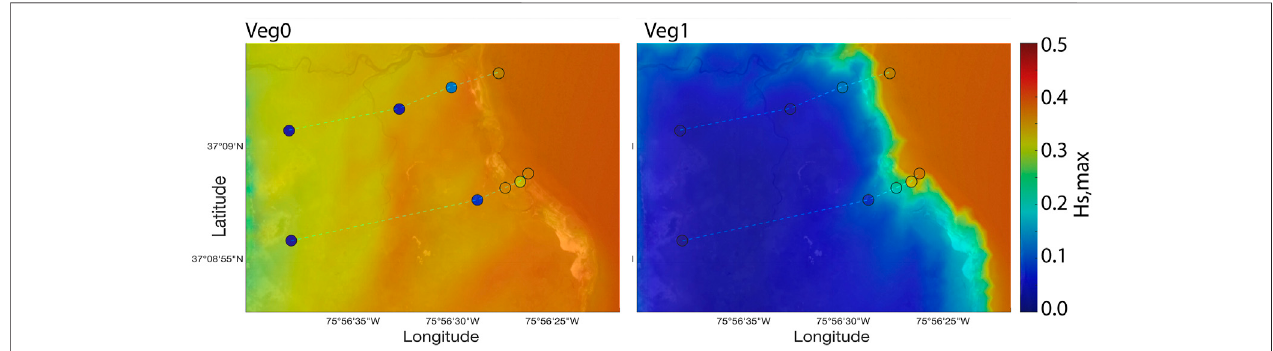
FIGURE 11 | Wave model sensitivity to wave – vegetation interaction in terms ofthe spatial distribution of the envelope of signi fi cant wave height H s , extracted from the modelwithoutwave – vegetation interaction(left)withwave – vegetation interaction (right). Theobservedmaximumvaluesat wavegaugelocationsare shown withthe